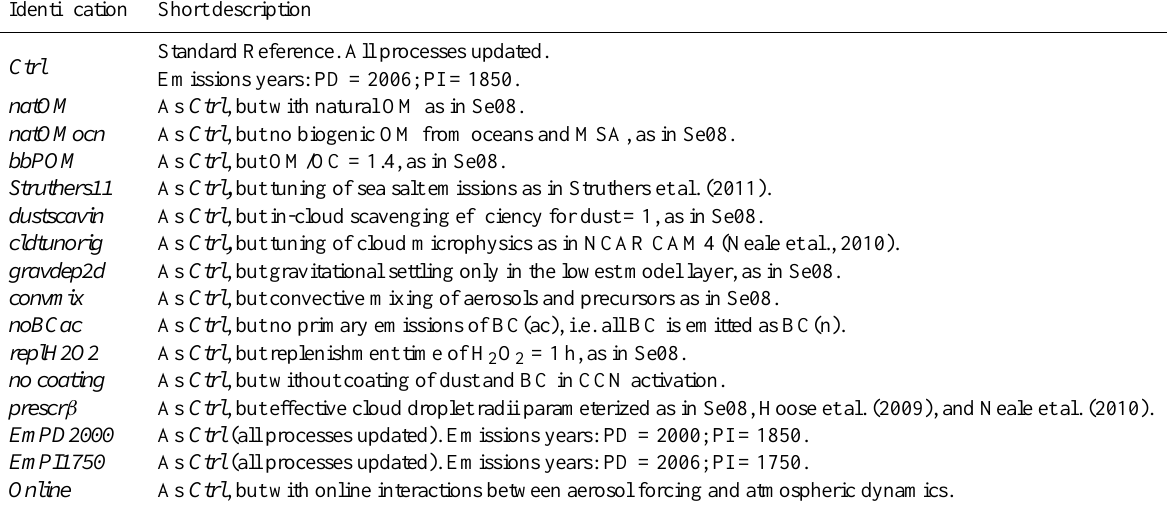
Table 5. Definition of sensitivity tests discussed in Sect. 5. Se08 refers to Seland et al. (2008). Note: Due to different cloud tuning, the cldtunorig experiments do not have the same meteorology as the other offline experiments (but PD and PI for cldtunorig have the same